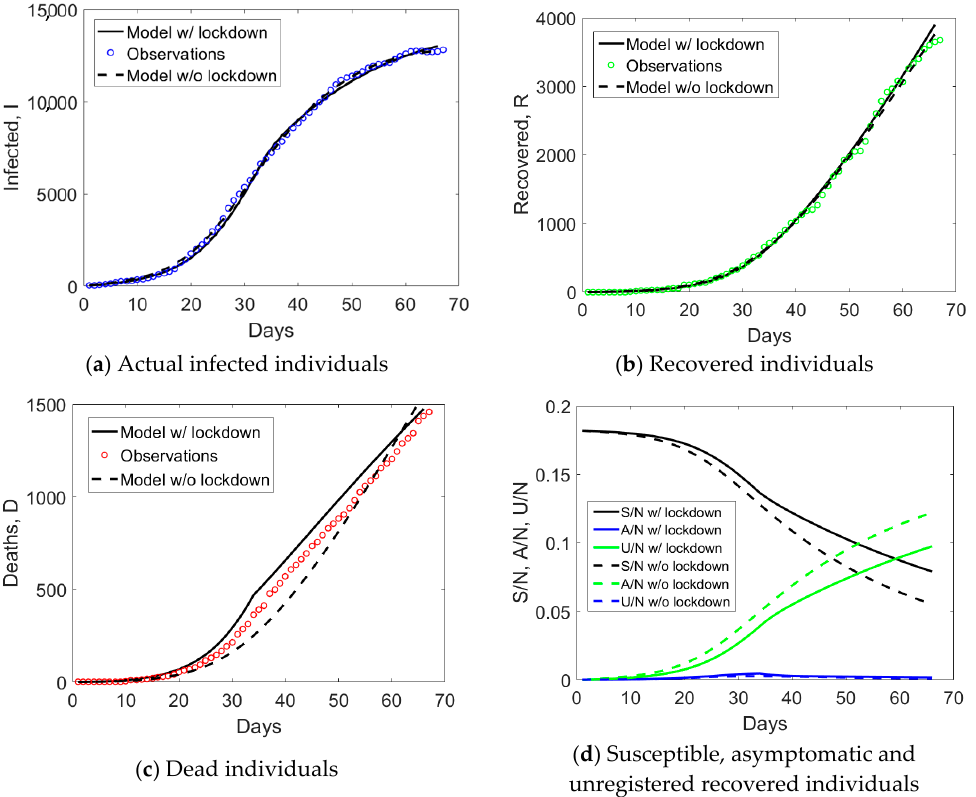
Figure 10. Simulated compartments including or excluding lockdown measures in the model, with time-dependent or time-independent parameters, for Veneto.